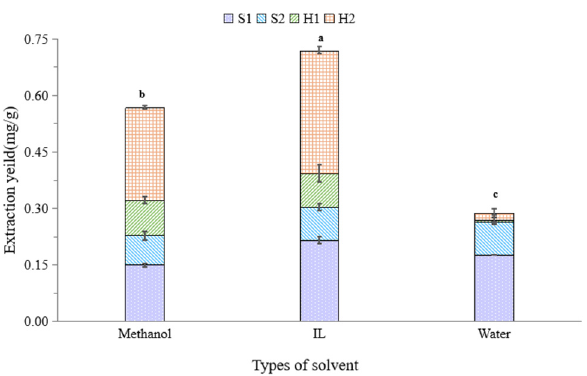
Figure 3. Comparison of extraction solvents on extraction yield. Different lowercase letters (a, b, c) indicated significant difference in extraction yield between different types of solvent with the same ZOJ tuber sample (p < 0.05).